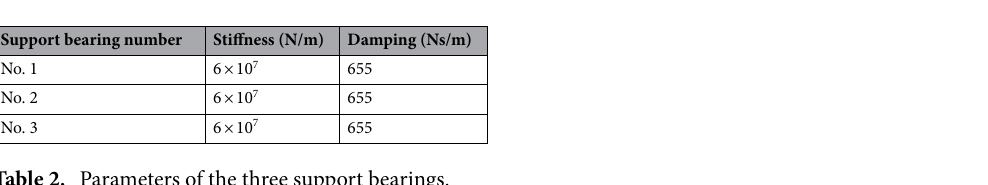
Table 2. Parameters of the three support bearings.